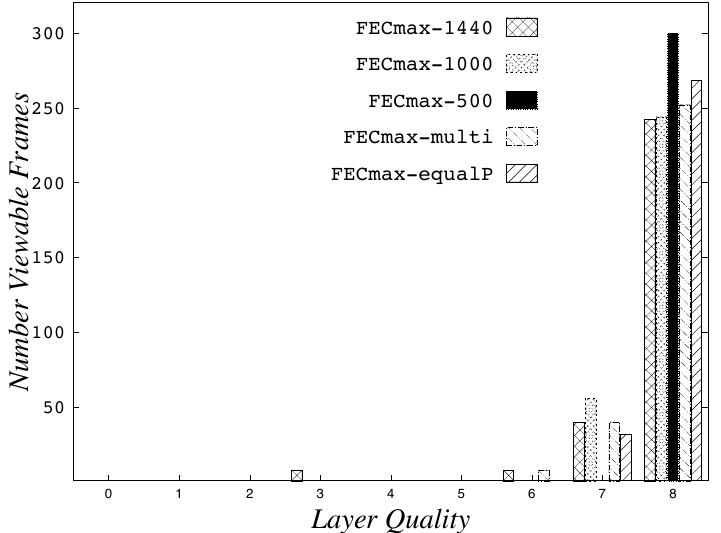
Figure A13. Example of the number of viewable layers for SVC-SC, for each of the FECPacket thres , at a packet loss rate of 10% and a GOP of 8. This image illustrates an increase in the FEC for C1 and C2 based on the worst case scenario, as shown in Table A2.